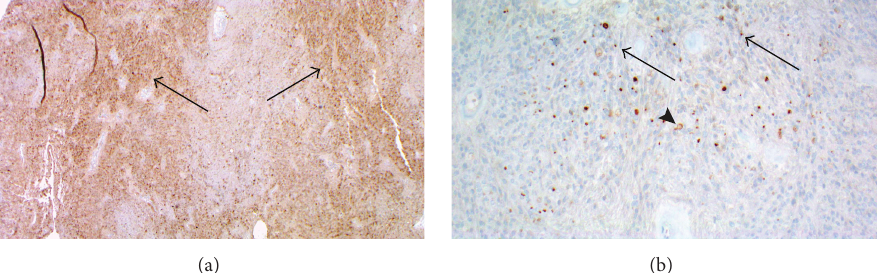
Figure 5: (a) Immunohistochemistry for synaptophysin, mag × 40, shows more intensive cytoplasmic staining in ependymal regions (arrows). (b) Immunohistochemistry for EMA, mag × 200, shows cytoplasmic, dot-like (arrows), and ring-like (arrowhead) cytoplasmic positivity in ependymal